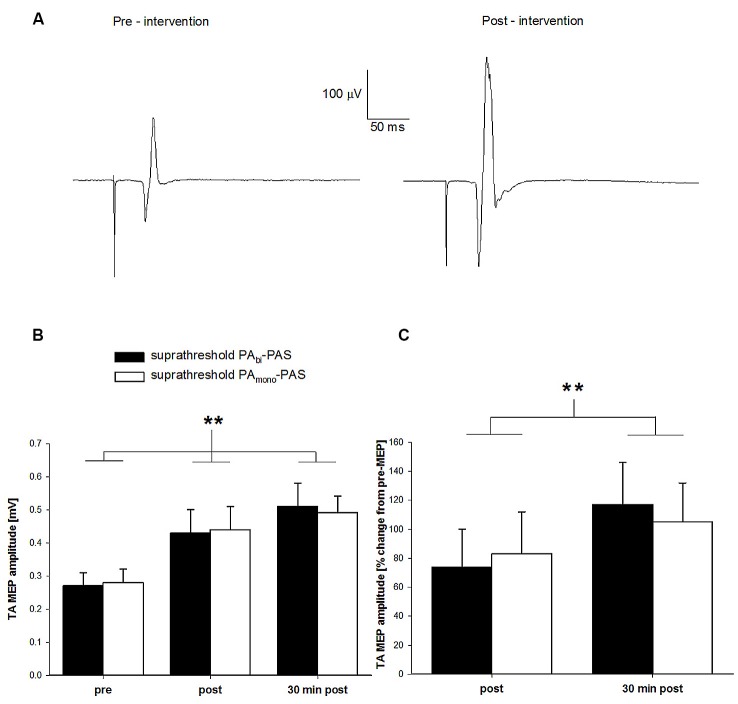
Change in tibialis anterior (TA) motor evoked potential (MEP) amplitude after suprathreshold PAbi-paired associative stimulation (PAS) compared to suprathreshold PAmono-PAS at rest. (A) TA MEP changes prior to and following the suprathreshold PAbi-PAS intervention for one participant. Data are the average of 16 trials. (B) TA MEP changes in mV, prior to, immediately following, and 30 min post suprathreshold PAbi-PAS (n = 11) compared to the suprathreshold PAmono-PAS (n = 11) intervention. Across both interventions, MEPs were significantly increased immediately after PAS (p = 0.018) and 30 min after PAS (p < 0.001) compared to before PAS. (C) TA MEP immediately following and 30 min post suprathreshold PAbi-PAS and suprathreshold PAmono-PAS interventions expressed as a percent change from values prior to the intervention. Asterisks in (B,C) denote significant differences. Error bars represent standard deviation.